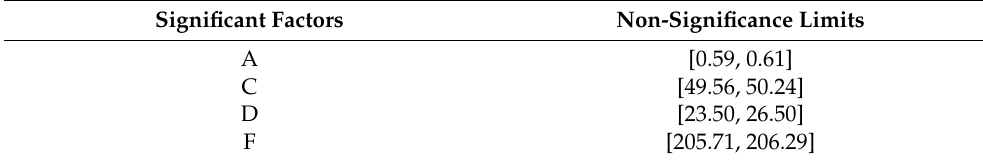
Table 9. Non-significant limits for factors A, C, D and F that influence the response Area EH. Significant